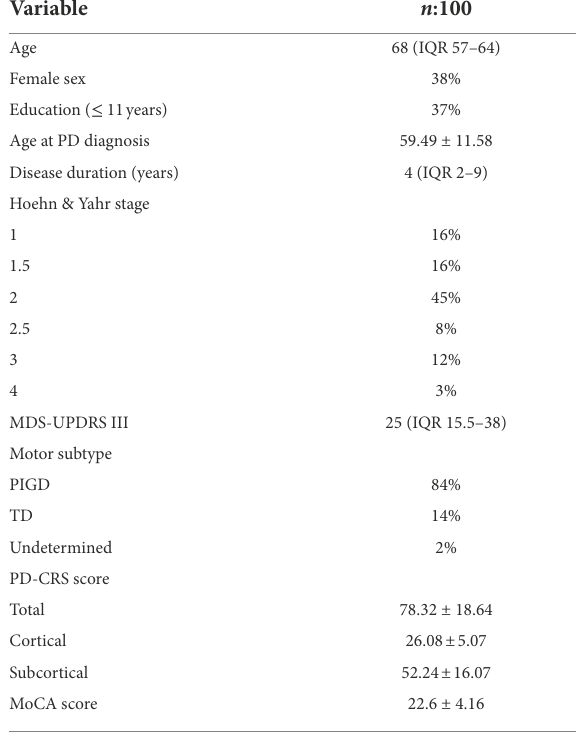
TABLE 1 Sociodemographic and clinical characteristics of the